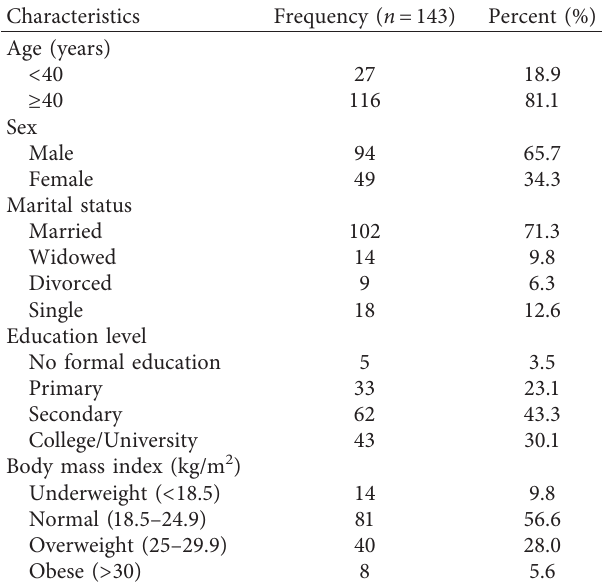
Table 1: Sociodemographic characteristics of the study population.